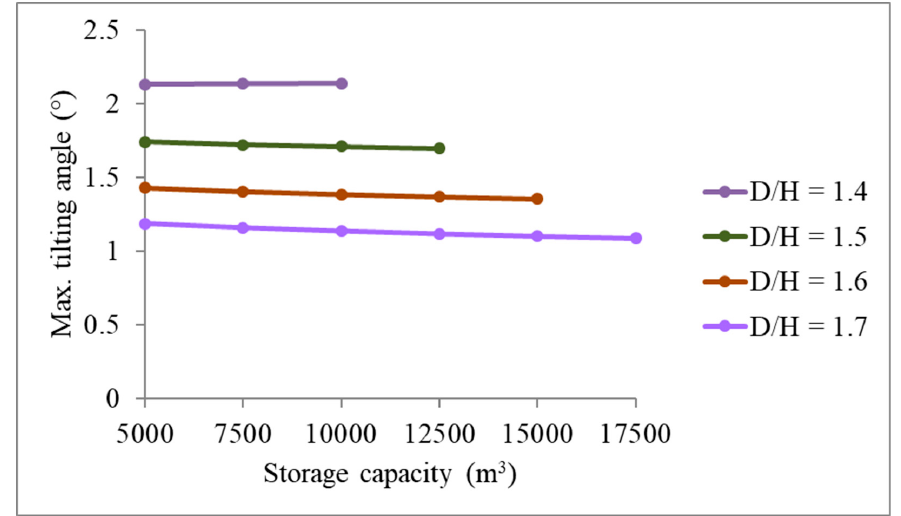
Figure 37. Maximum tilting angle of single hull cylindrical tank (5000–17,500 m 3 ) under working environmental conditions.